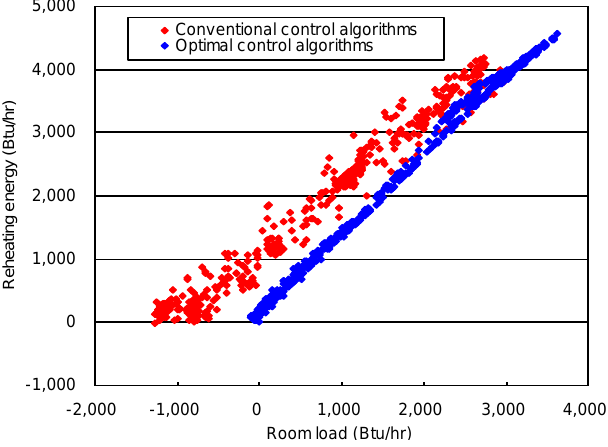
Figure 13. Comparison of reheating energy between conventional minimum airflow rate and variable minimum airflow